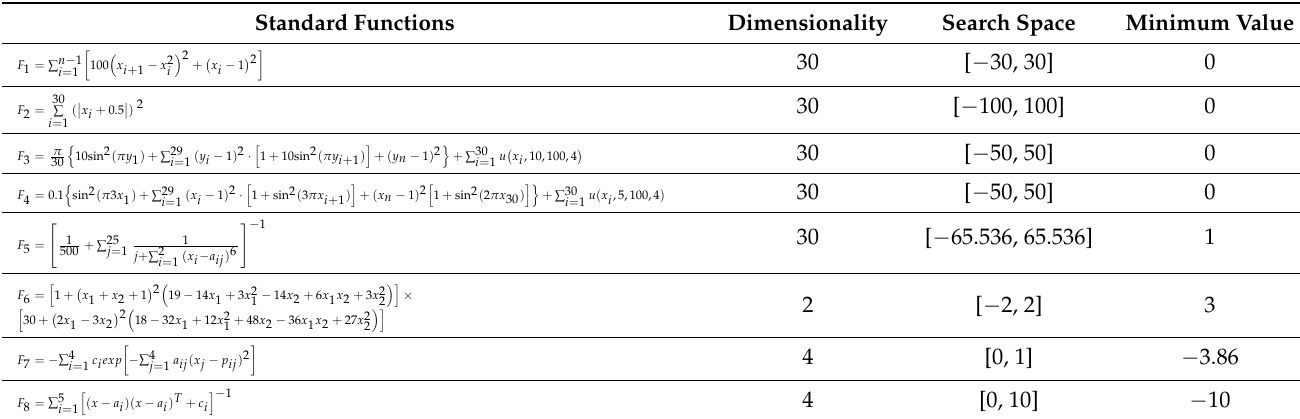
Table 2. Standard test